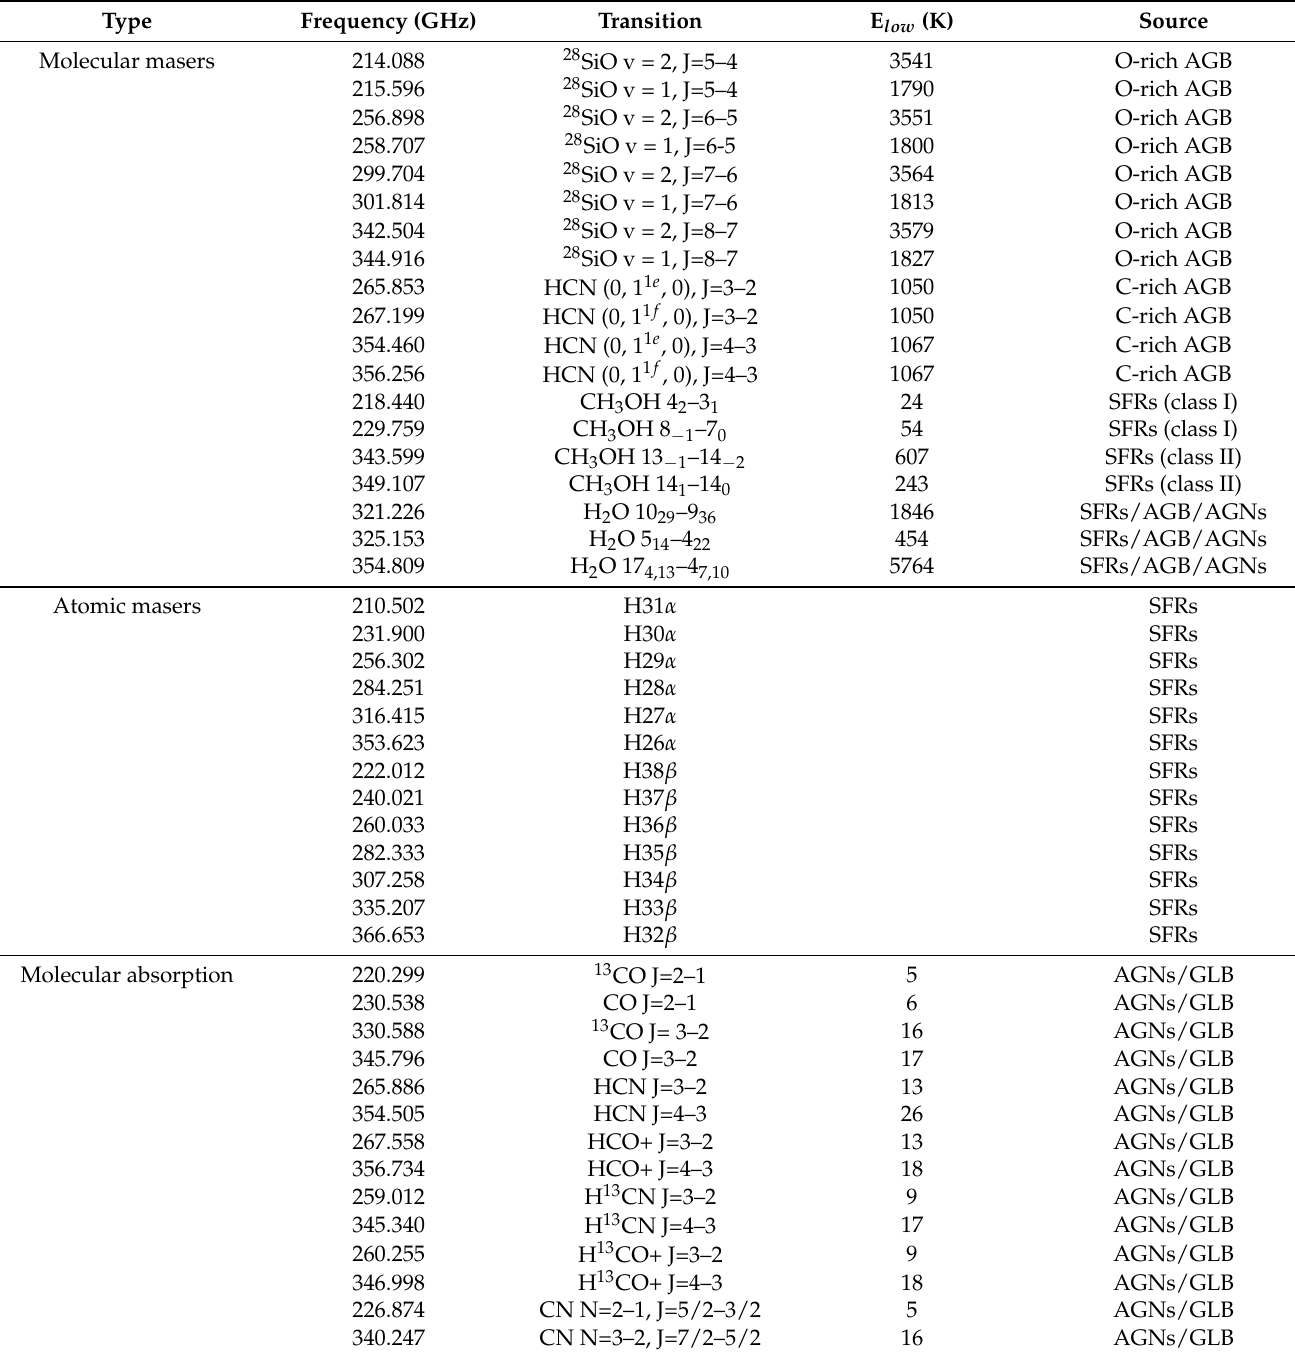
Table 4. Selected spectral lines near 230GHz and 345GHz and their energy level above ground state. Three different types of spectral lines available for VLBI observations are listed with physical